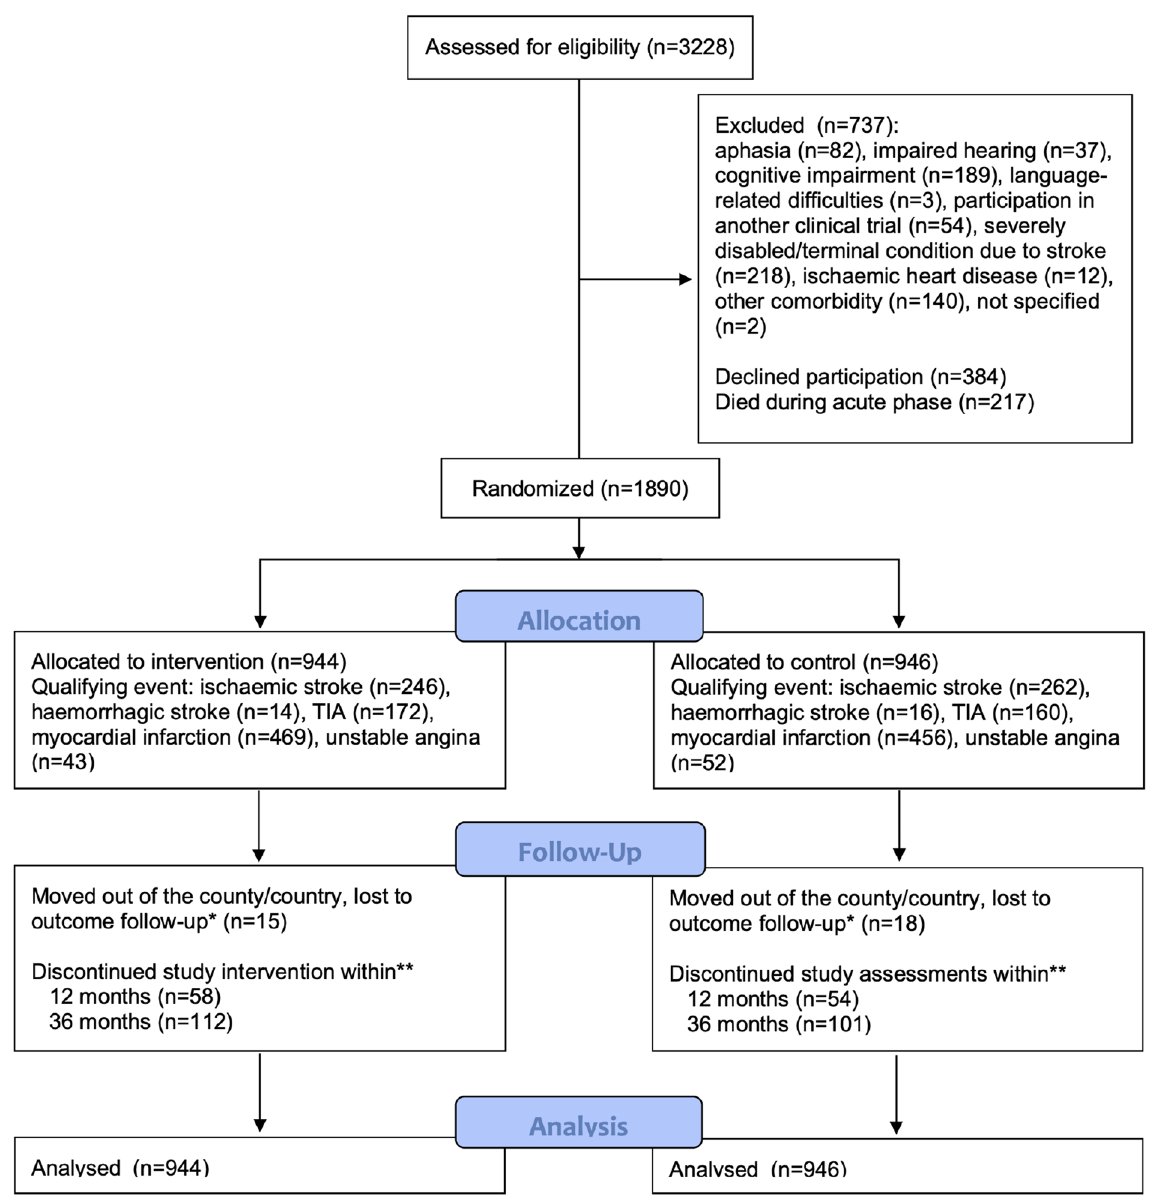
Figure 1. Study flow chart. *Patients who moved were censored from the outcome analysis at the date they moved or, when unavailable, the date of the last documented medical contact. **Cumulative